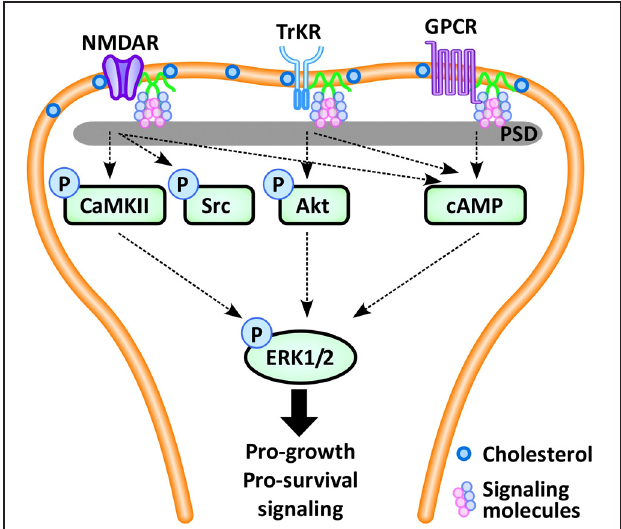
FIGURE 2 | In the neuron, pro-survival signaling occurs via multiple synaptic signaling receptors, including the NMDA glutamate receptor (NMDAR), the neurotrophin-activated tyrosine kinase B receptor (TrkR), and G-protein coupled receptors (GPCRs), which converge via intracellular protein kinases (CaMKII, Src, Akt, cAMP) to phosphorylate extracellular-signal regulated kinase 1/2 (ERK1/2), leading to expression of pro-survival and pro-growth genes. These pro-survival receptors localize and concentrate within the post-synaptic density (PSD), a region enriched in caveolins, cholesterol and glycosphingolipids. (Definitions: CaMKII, calcium/calmodulin-dependent protein kinase II; cAMP, cyclic adenosine